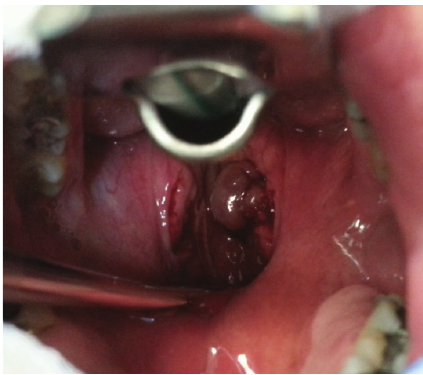
Figure 1: Intraoperative photo: KS involved right tonsil.